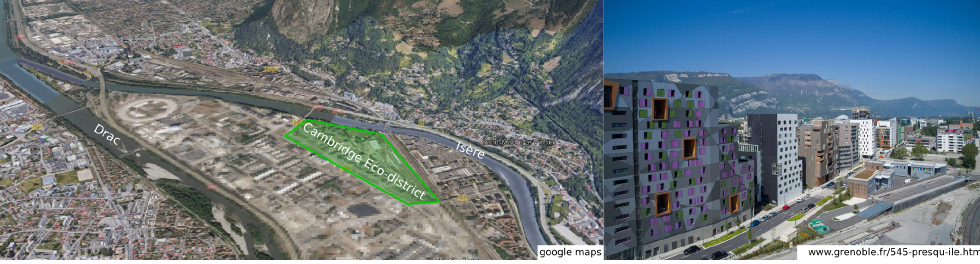
Figure 2. Grenoble “Cambridge Eco-district”